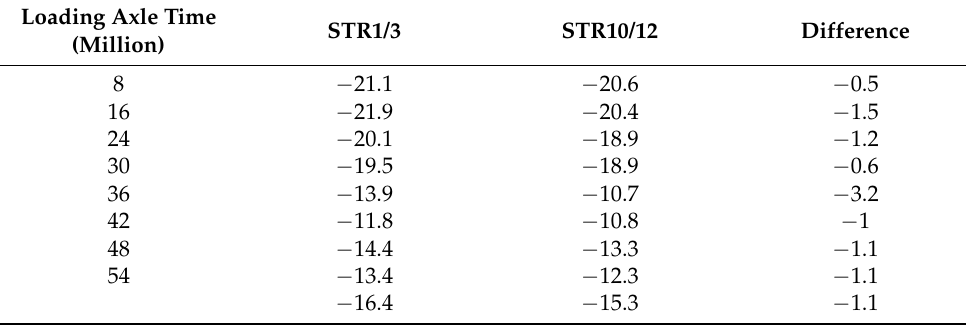
Table 4. Comparison of STR1/3 and STR10/12 characteristic temperature T 2 .